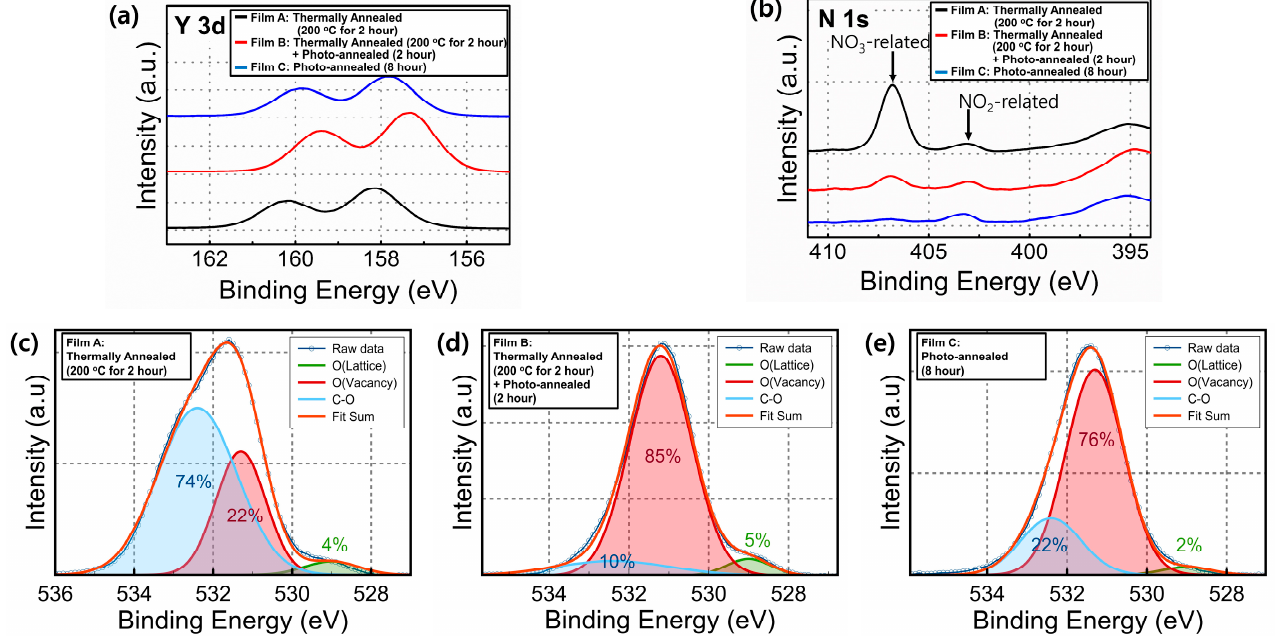
Figure 4. ( a ) Y 3d, ( b ) N 1s, and ( c – e ) O 1s XPS spectra of the sol–gel-processed Y 2 O 3 films obtained under different annealing treatments.